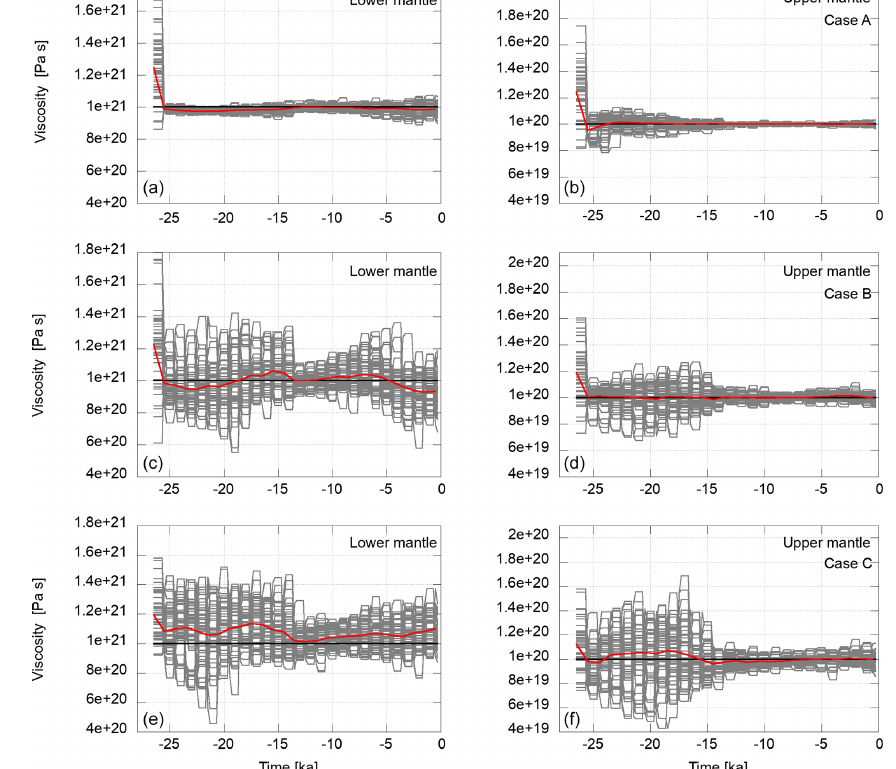
Figure 6. Variations in the viscosity in the course of the assimilation in the lower mantle (a, c, e) and the upper mantle (b, d, f) for scenario one (Cases A–C; from top to bottom) in grey. The flat segments represent the viscosity values of an ensemble member during the forecast phase. When observations are available, a model state may be resampled and perturbed. This changes the viscosity values as shown. The horizontal black lines represent the viscosities of the reference experiment towards which the ensemble mean is expected to converge. The red lines are the weighted ensemble means. Ensemble members are weighted by the likelihood of the observations given the current member model state.